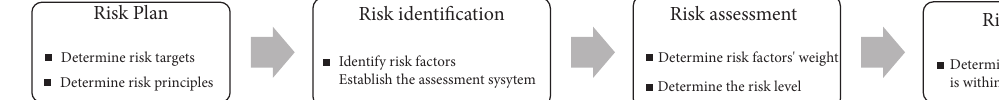
Figure 1: Risk management steps.